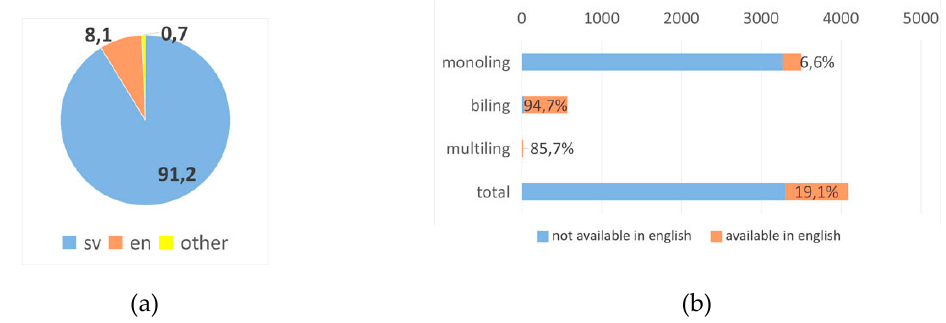
Figure A27. Visualization of the results for domain se. ( a ) Primary languages pie chart and ( b ) English